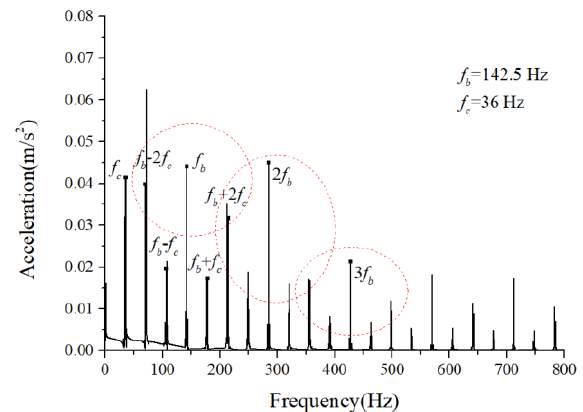
Figure 31. Acceleration waveform.